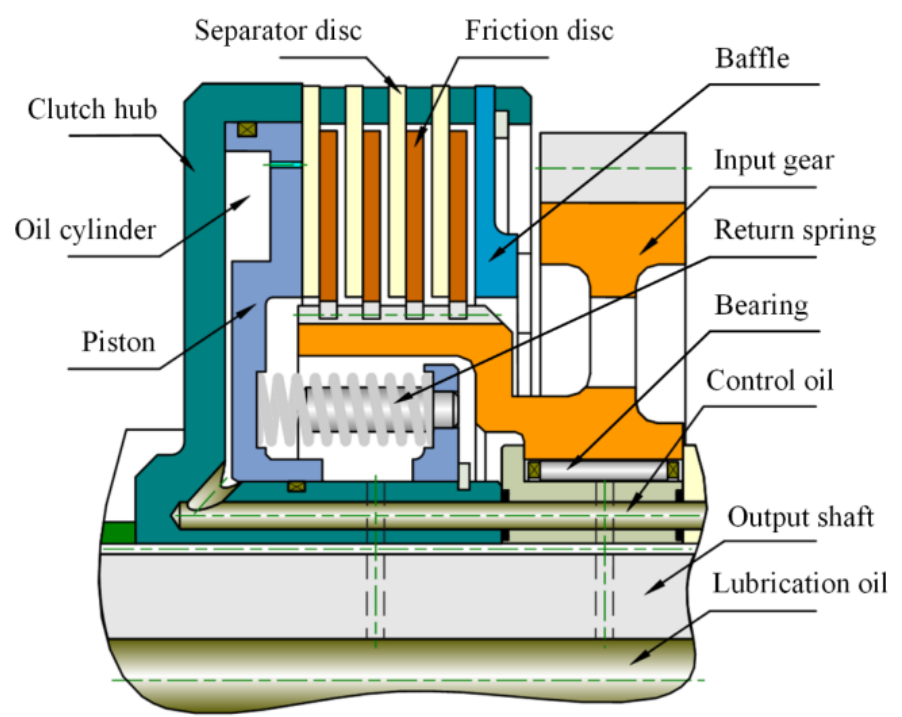
Figure 1. Structure of the wet multi-disc clutch.